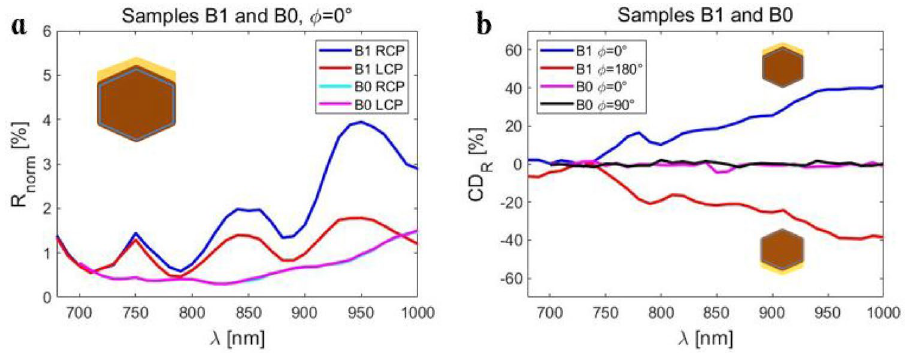
Figure 4. ( a ) Samples B1 and B0: RCP and LCP reflection spectra for Samples B1 and B0. The inversion of the CD R sign between